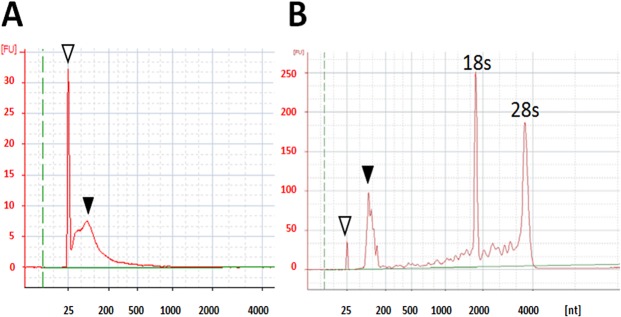
Representative electropherogram of RNA samples prepared from bovine plasma exosome (A) and skeletal muscle (B) Open and closed triangles indicate peak front and small RNA, respectively.